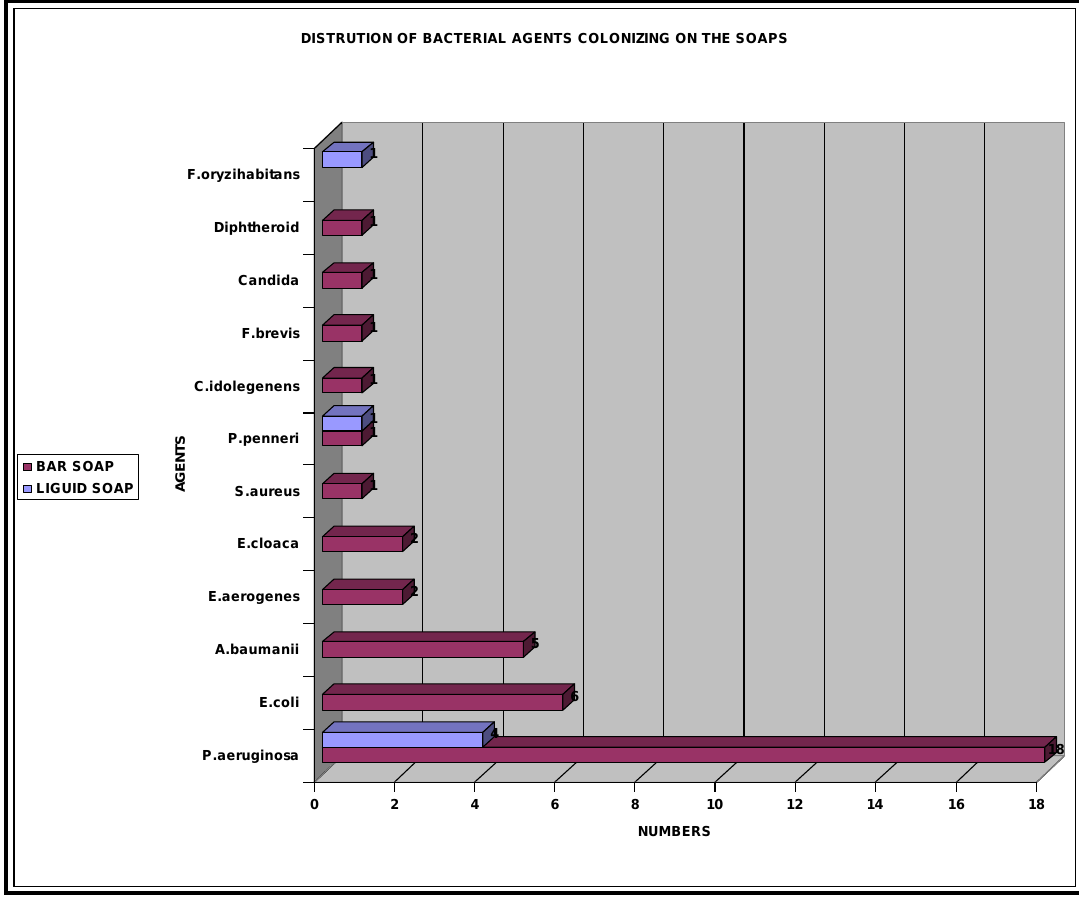
Figure 1. Distribution of bacterial agents colonizing on the soaps